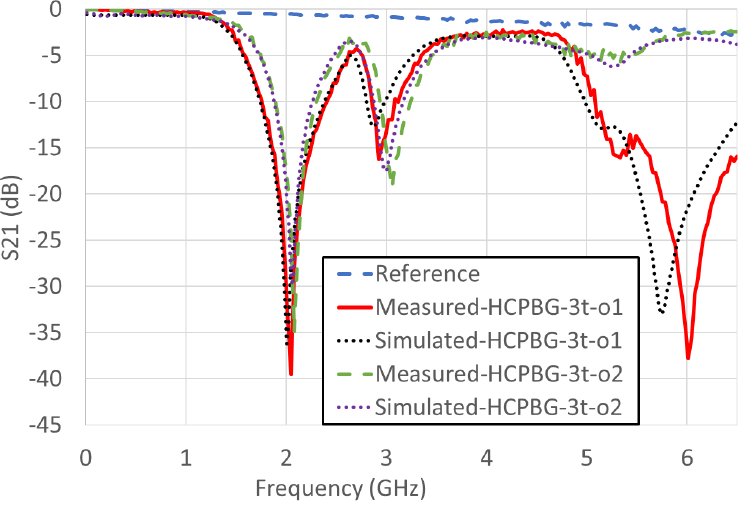
Figure 10. Measurement—transmission loss for HCPBG with 3 traces, orientations 1 and 2.